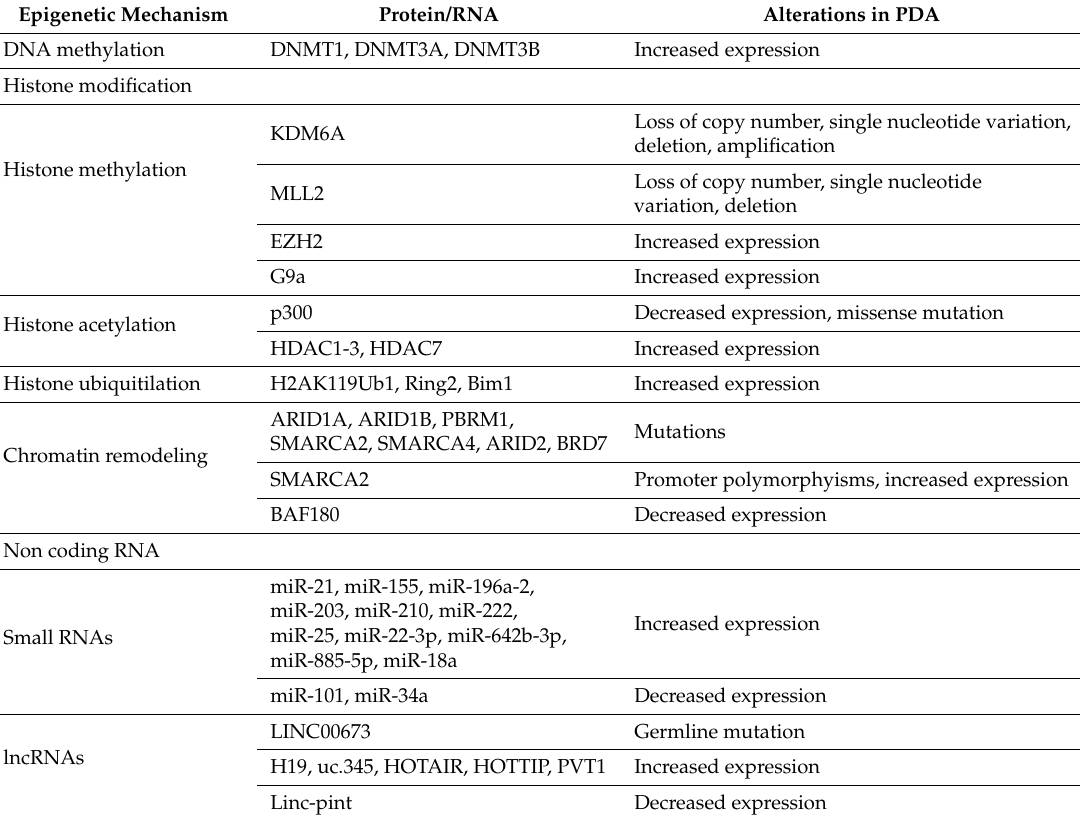
Table 1. Overview of epigenetic alterations in pancreatic ductal adenocarcinoma (PDA)—see text for details and